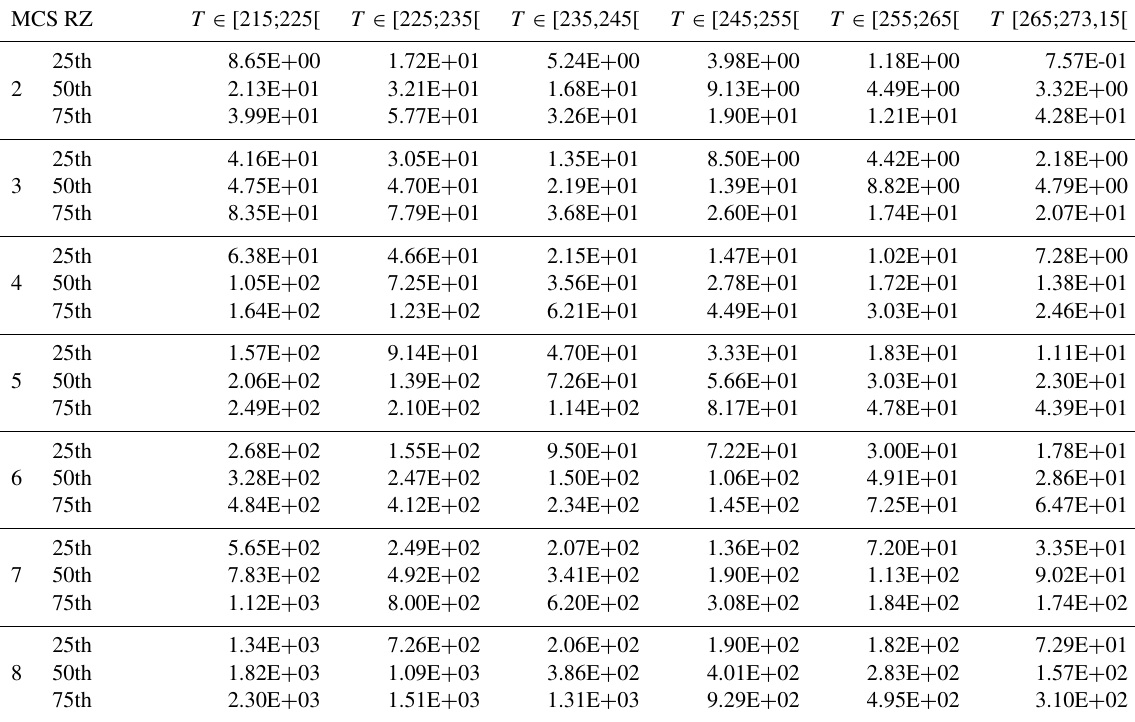
Table C5. Total concentration since 50µm ( N T 50 ) in L − 1 (Fig. 9). MCS